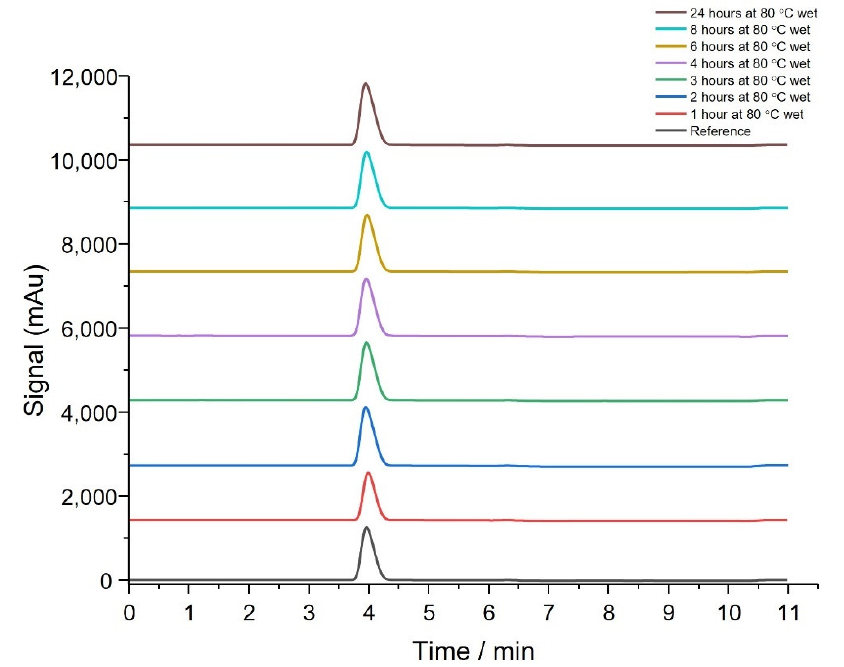
Figure 3. HPLC analysis showing the thymoquinone: hydroxypropyl- β -cyclodextrin was stable after forced heat degradation (wet) ( n = 6).